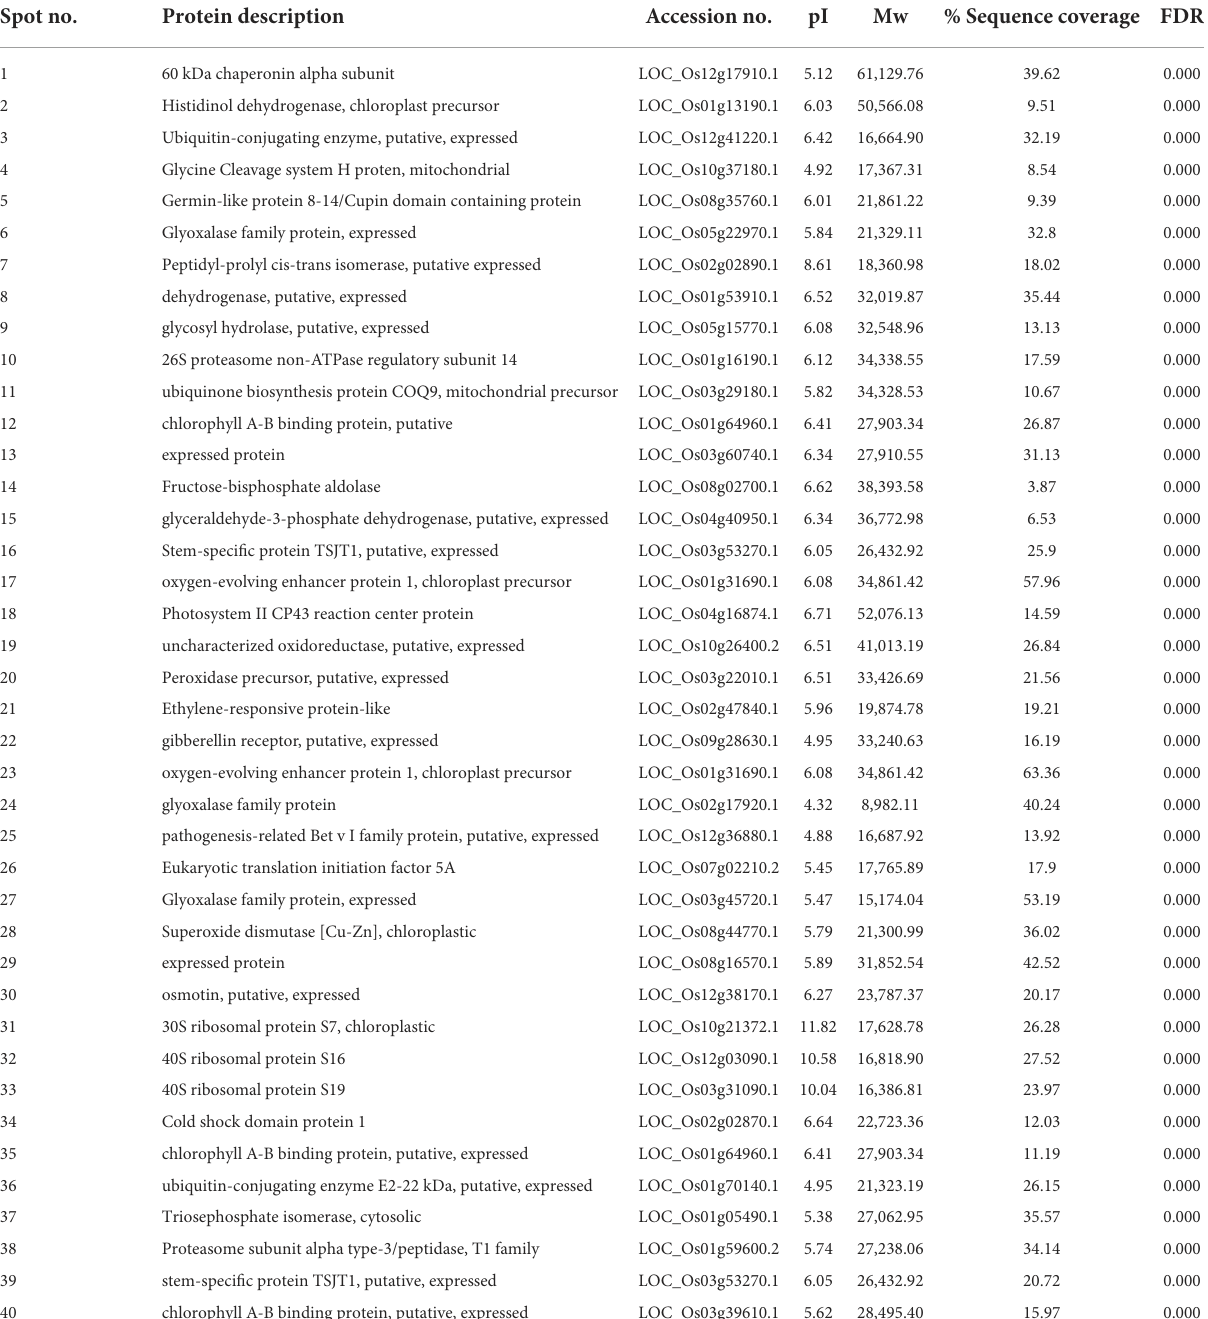
TABLE 1 List of proteins in rice leaves under UV-B stress identified by mass spectrometry. Spot